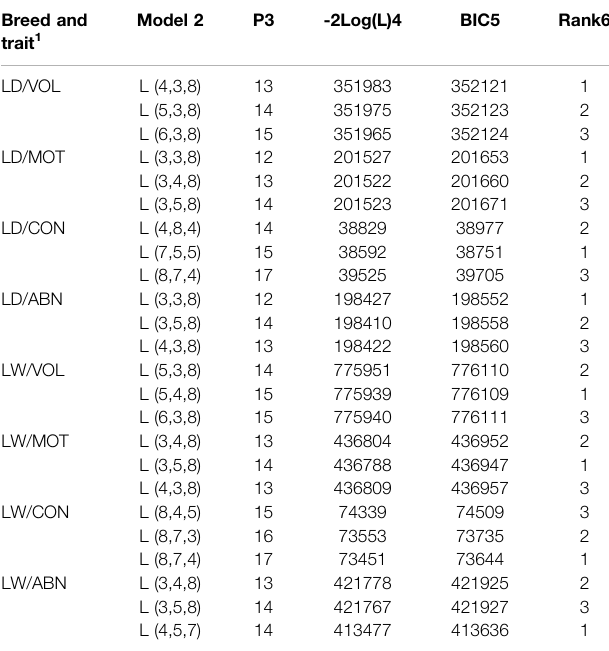
TABLE 3 | Order of fi t for fi xed (L F ), additive genetic (L A ), and permanent environmental